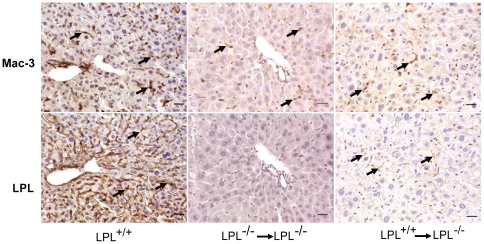
Immunocytochemical detection of macrophage and LPL staining in wild-type, LPL-/- mice transplanted with bone marrow from wild-type or LPL-/- mice, appeared in brown.Representative images show macrophages (upper panel) and LPL protein (lower panel) stain in paraffin sections of liver. Bars represent 20 µm.